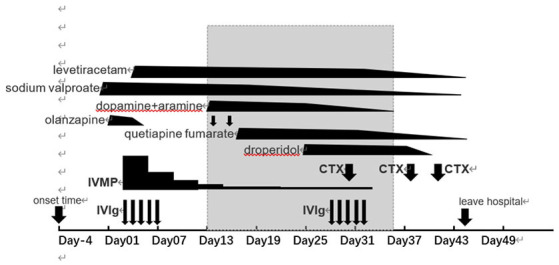
The clinical course. Gray bands indicate the length of time a patient has had intractable hypotension. IVIg, intravenous immunoglobulin; IVMP, intravenous methylprednisolone; CTX, cyclophosphamide.